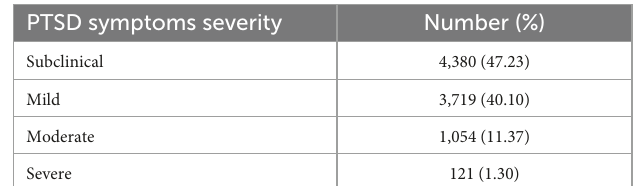
TABLE 1 Percentage of the different order of severity of PTSD symptoms.